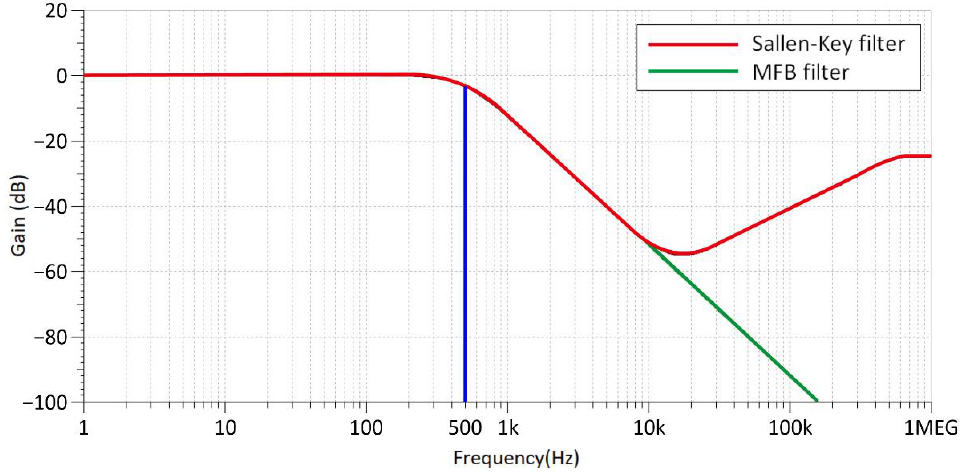
Figure 4. Frequency response of the MFB filter architecture and Sallen – Key filter.